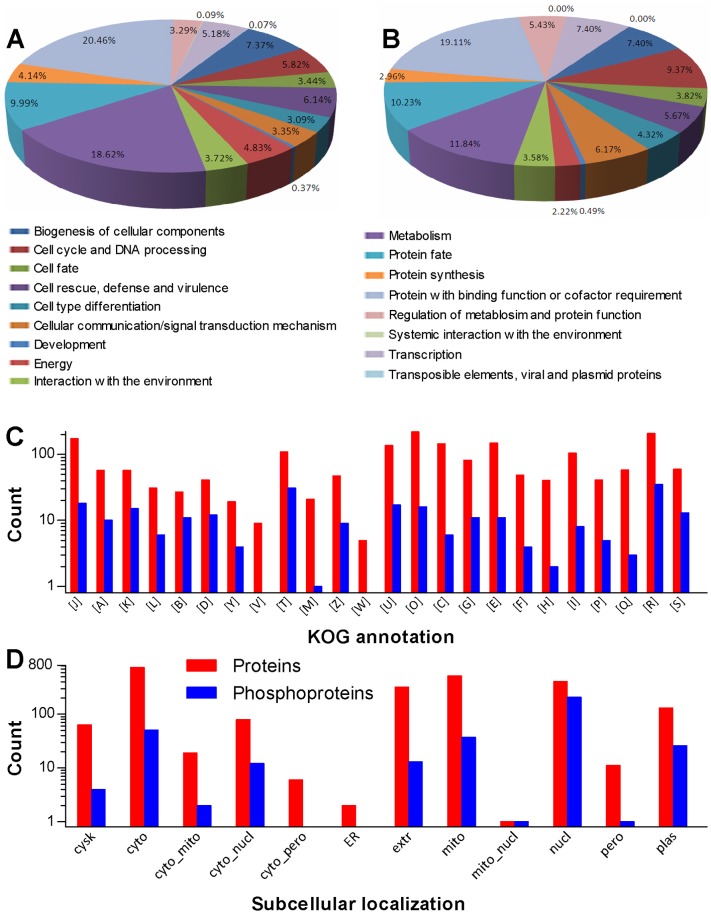
Quantification of B. bassiana Cdc14-specific proteome and phosphoproteome.(A, B) FunCat annotation of quantified proteins and phosphoproteins respectively. (C) KOG classification. (D) Subcellular localization predicted with WoLF PSORT.